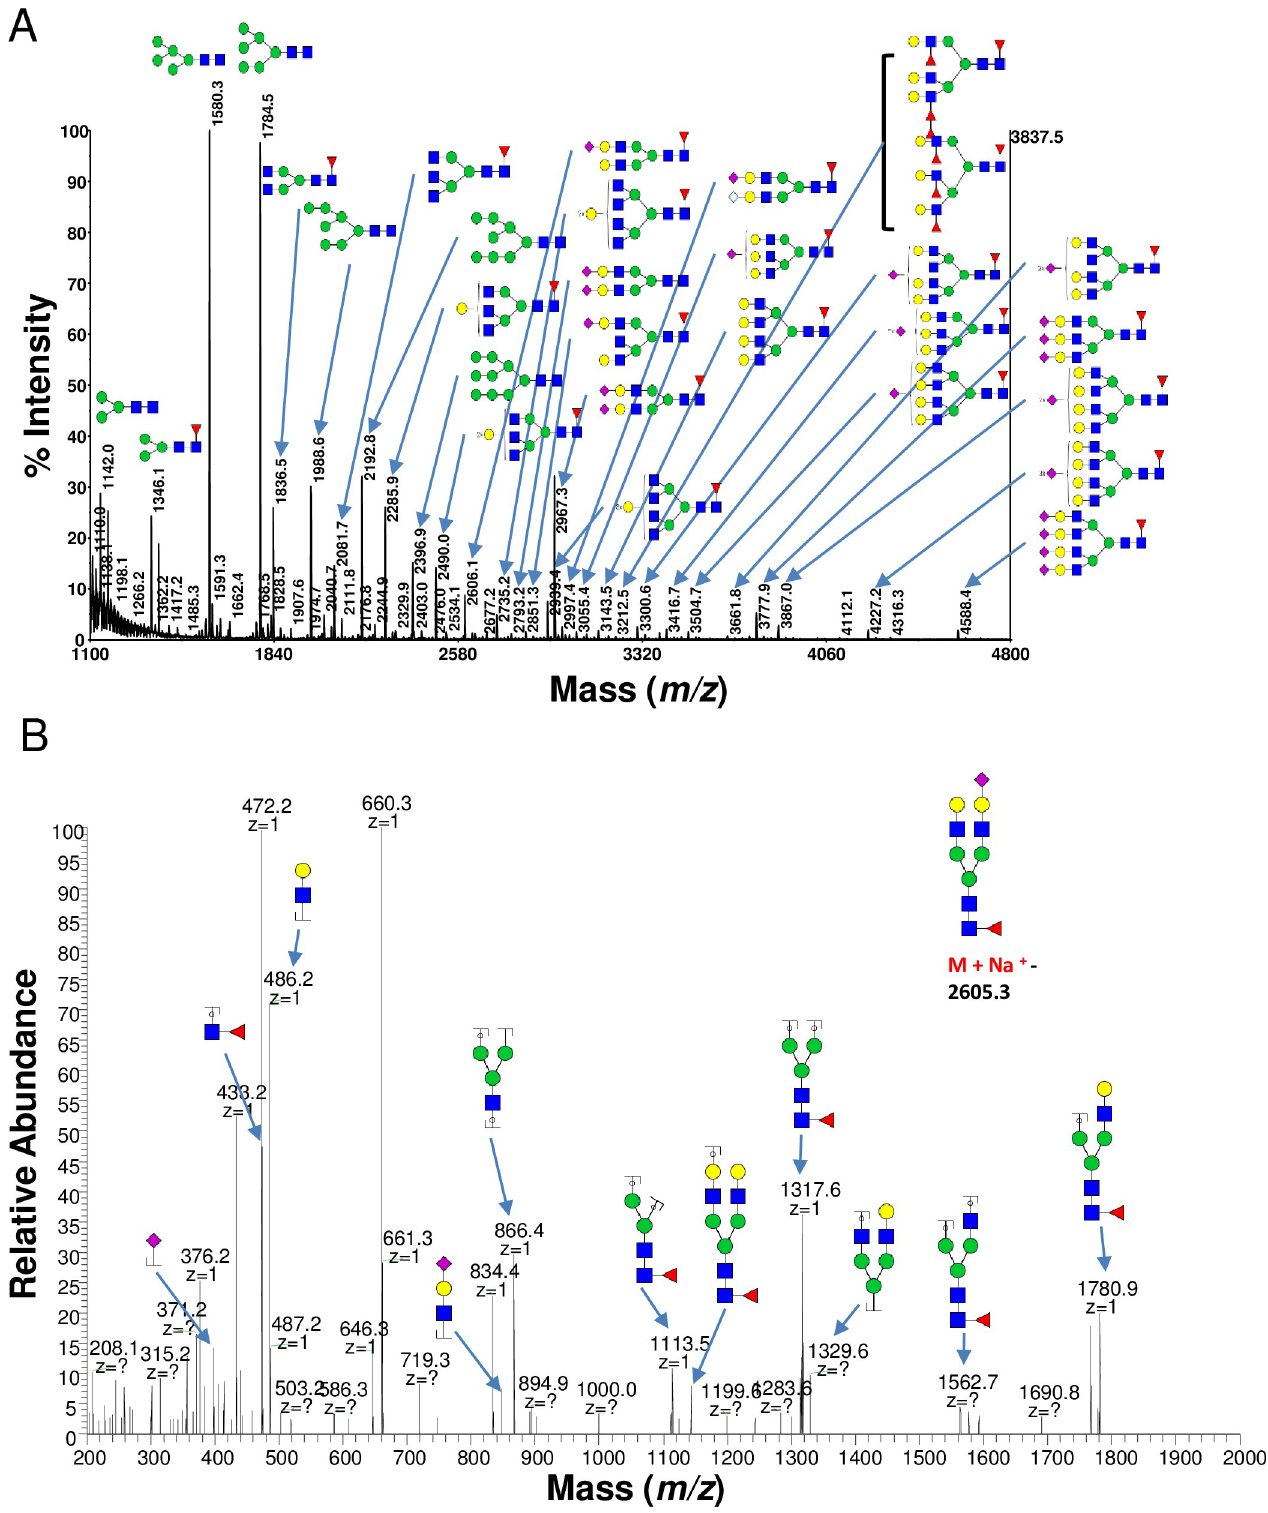
Fig 1. The representative MALDI-TOF-MS and ESI-MS/MS spectrum of N -glycans. MALDI-TOF-MS spectrum of permethylated N -glycans released by PNGaseF (A) and representative HCD MS2 fragmentation spectra at m/z 884 (3+) [M + Na]1+ ! 2605.3 (B).